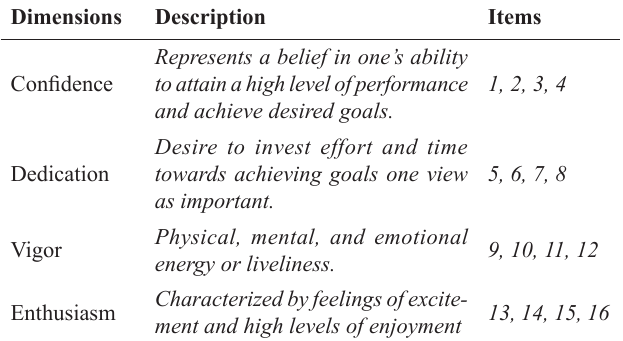
Table 1. Dimensions, description and corresponding items of the original version of the Athlete Engagement Questionnaire (Lonsdale, Hodge, & Jackson , 2007, p.472).